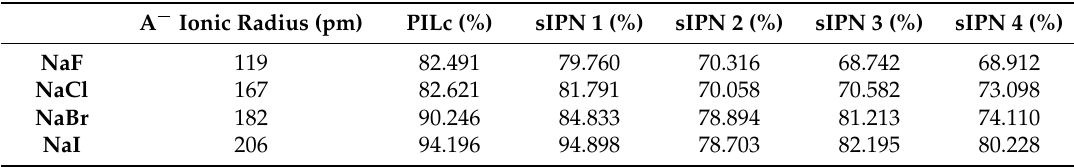
Figure 10. The shrinking effect of 1% w/w NaF, NaCl, NaBr and NaI solutions on the area of the hydrogels compared to DI water. Table 4. Salt-induced shrinking of the hydrogels in area % compared to DI water.